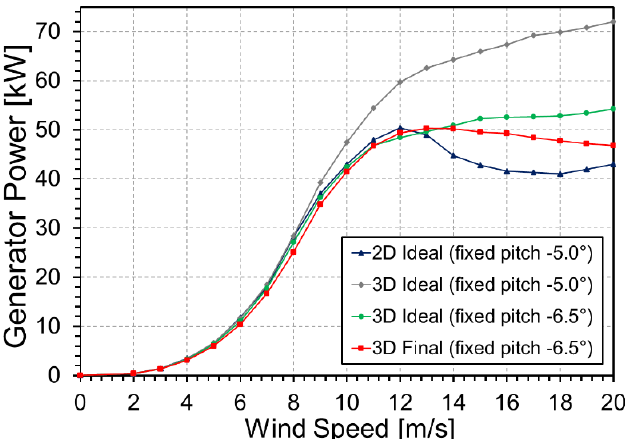
Figure 3. Generator power as a function of wind speed for the stall-regulated ideal blade design with 2D lift and drag coefficients, the ideal design with 3D effects, and the final design with 3D effects.